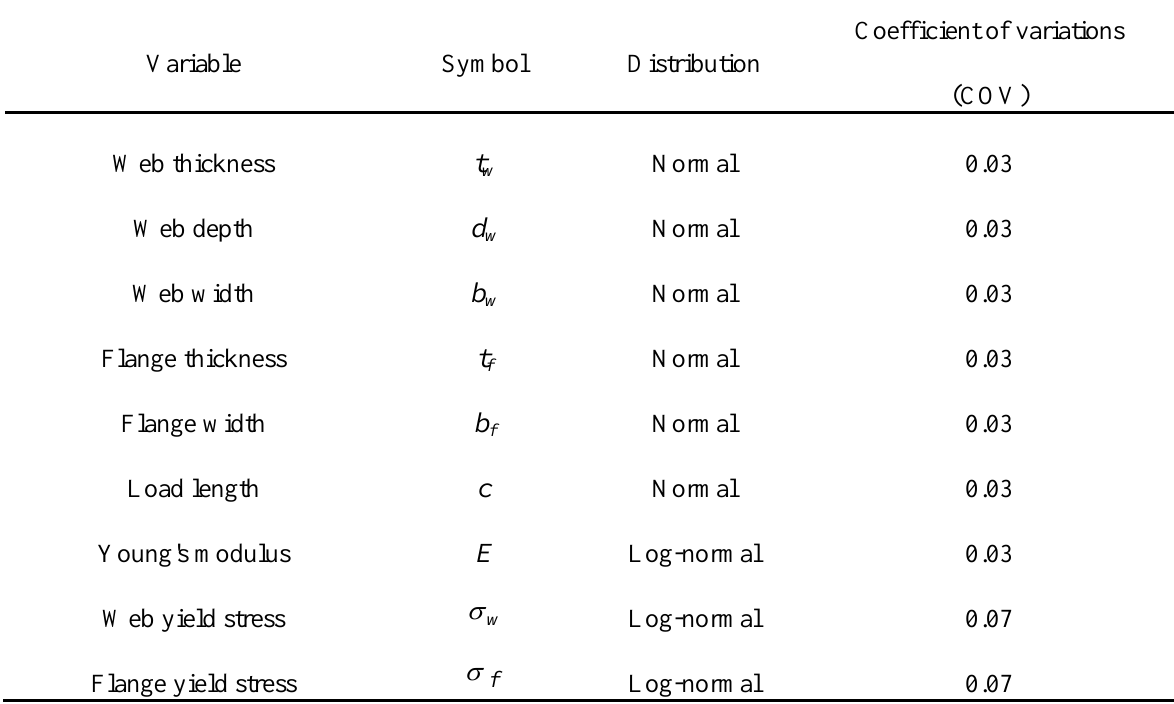
Table 5. Statistics of random resistance